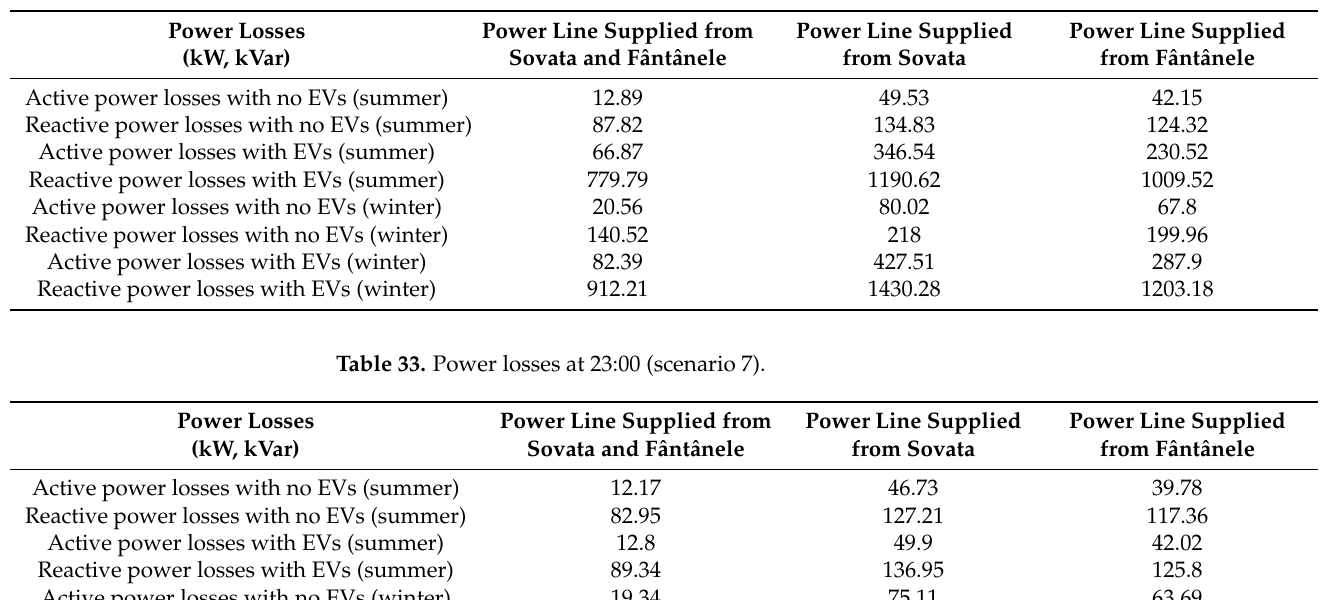
Table 32. Power losses at 22:00 (scenario 7).